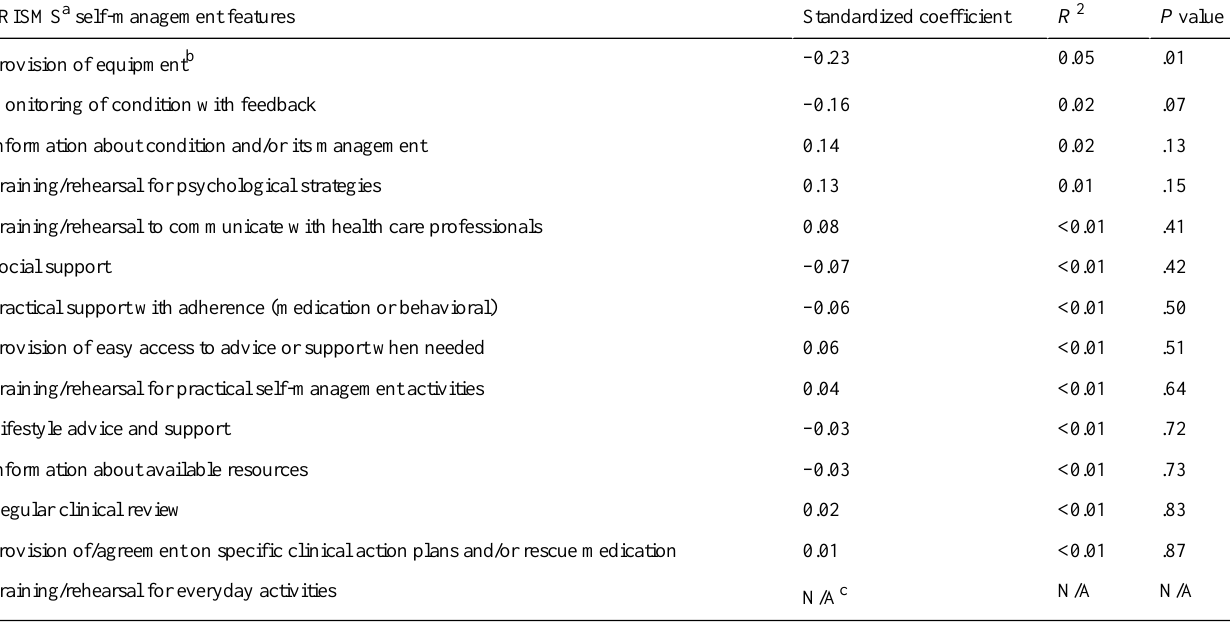
Table 3. R 2 and P values of a simple regression analysis at 5% significance level for user ratings (Data were sorted by the P values in ascending